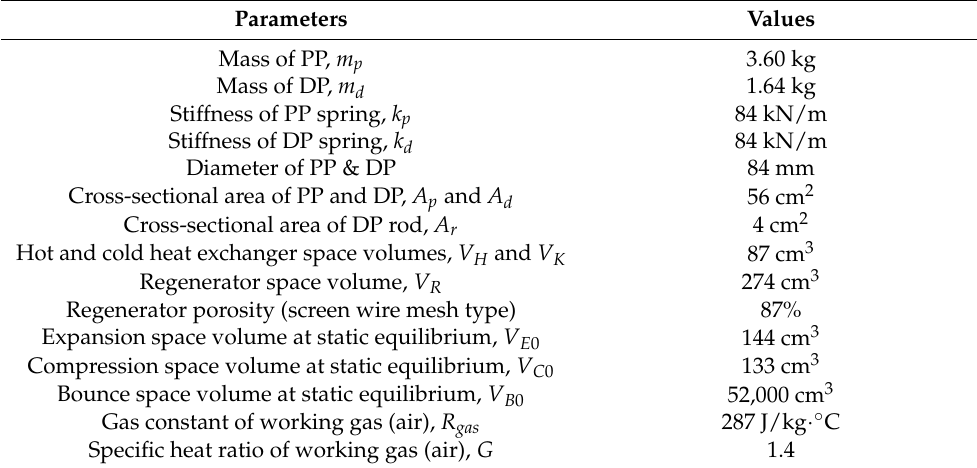
Table 1. Dimensions and specifications of the test FPSE (working gas is air). Parameters Values Mass of PP, m p 3.60 kg Mass of DP, m d 1.64 kg Stiffness of PP spring, k p 84 kN/m Stiffness of DP spring, k d 84 kN/m Diameter of PP & DP 84 mm Cross-sectional area of PP and DP, A p and A d 56 cm 2 Cross-sectional area of DP rod, A r 4 cm 2 Hot and cold heat exchanger space volumes, V H and V K 87 cm 3 Regenerator space volume, V R 274 cm 3 Regenerator porosity (screen wire mesh type) 87% Expansion space volume at static equilibrium, V E 0 144 cm 3 Compression space volume at static equilibrium, V C 0 133 cm 3 Bounce space volume at static equilibrium, V B 0 52,000 cm 3 Gas constant of working gas (air), R gas 287 J/kg · ◦ C Specific heat ratio of working gas (air), G